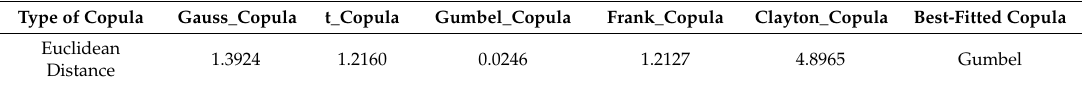
Figure 14. Bivariate frequency histogram based on wind speeds of Qiaodong II and Changxi I. Table 4. Euclidean distance between Copulas and empirical Copula. Table 4. Euclidean distance between Copulas and empirical Copula. Table 4. Euclidean distance between Copulas and empirical